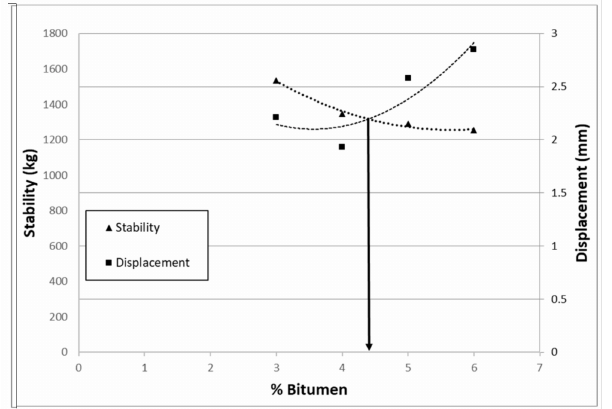
Figure 7. Choice of optimal bitumen percentage after marshal test.